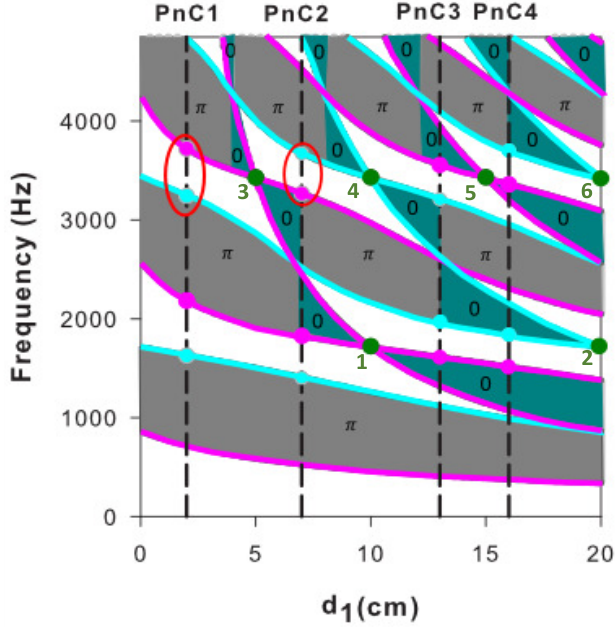
Figure 2. Bandgaps (white area) separated by bands (shaded area) of an infinite PnC as a function of d 1 , while d (cid:48) is fixed at 10 cm. The green circles labeled 1 to 6 indicate the positions of the band 1 crossing points (where the dispersion curves become flat). The vertical dashed lines correspond to the four PnCs discussed in Figure 3. Pink and cyan colors indicate the symmetric and antisymmetric edge modes of the common bandgaps, respectively. The bands with π and 0 Zak phases are indicated by gray and dark cyan colors,